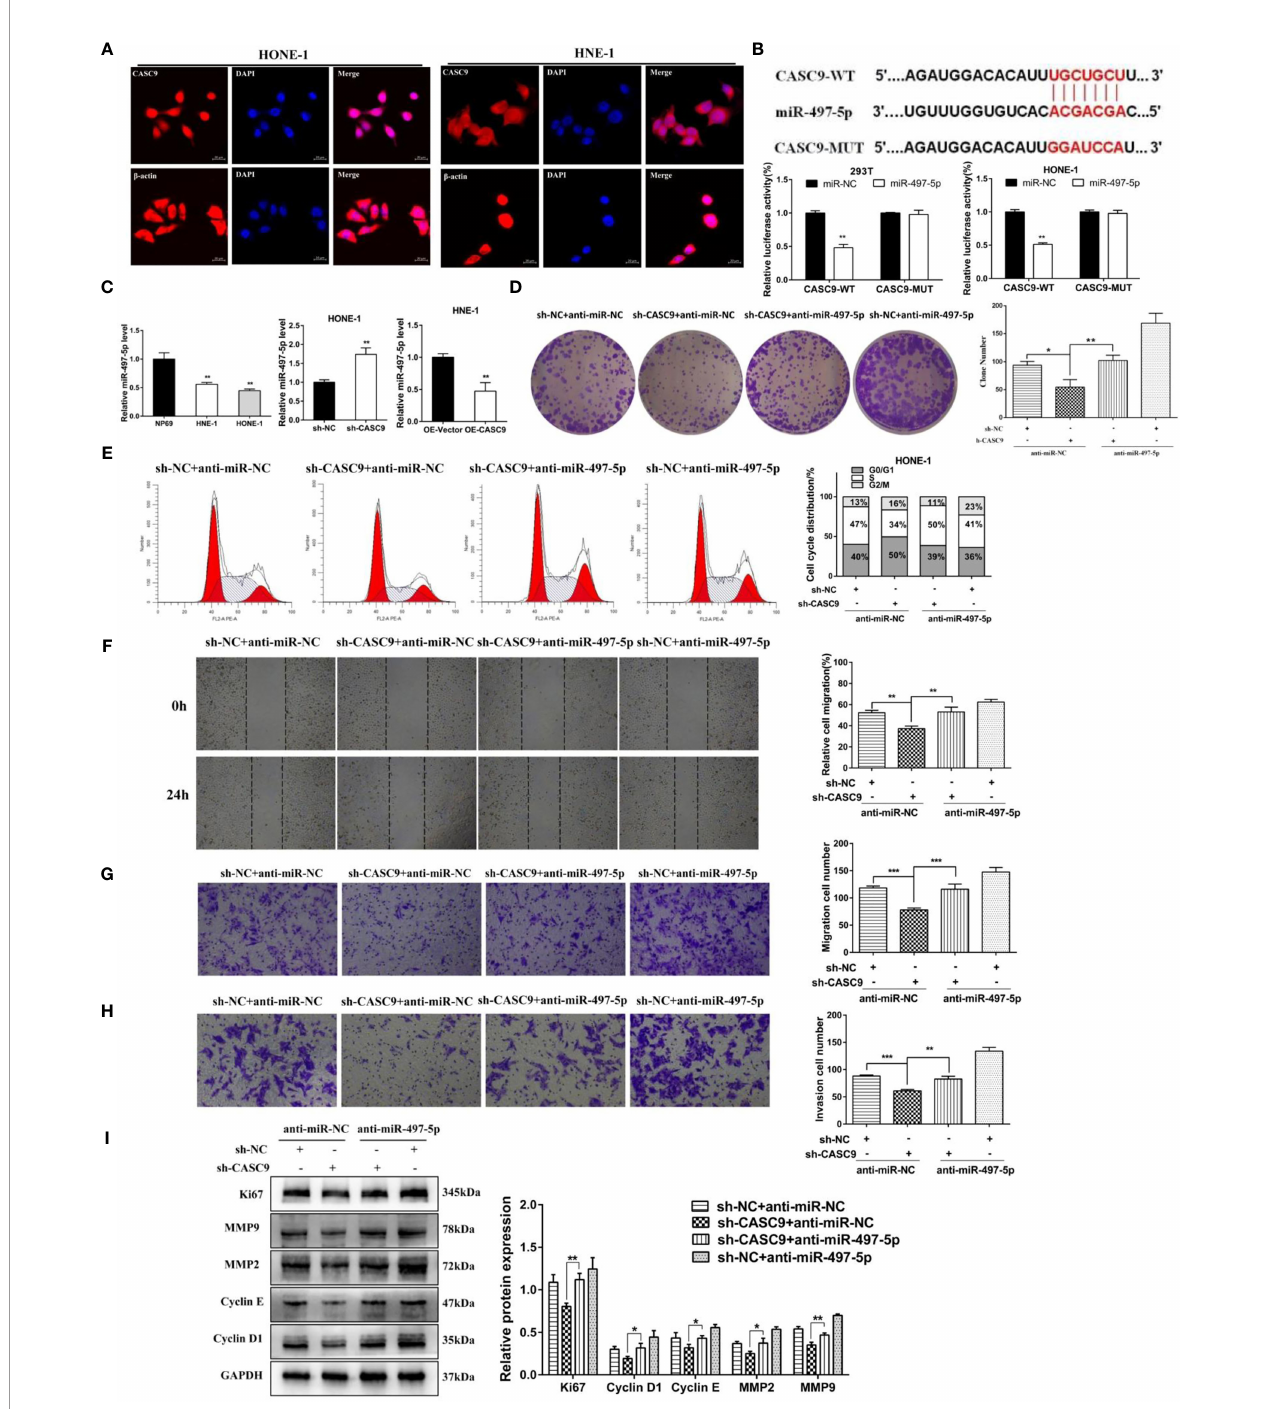
FIGURE 5 | miR-497-5p was a direct target of CASC9 and the abrogation of miR-497-5p reversed the inhibitory effects of the CASC9 knockdown on NPC cells. (A) RNA-FISH results revealed that CASC9 was distributed in both nucleus and cytoplasm of NPC cells. (B) The binding sites of miR-497-5p and CASC9 were predicted through bioinformatics analysis and con fi rmed by dual-luciferase reporter gene assay. (C) miR-497-5p expression was decreased and negatively associated with CASC9 in NPC cells. (D, E) Knockdown of miR-497-5p reversed the effect of silencing CASC9 on cell proliferation and cell cycle. (F, G) Knockdown of miR-497-5p reversed the effect of silencing CASC9 on cell migration. (H) Knockdown of miR-497-5p reversed the effect of silencing CASC9 on cell invasion. (I) The expression of proliferation and invasion-related proteins were determined using western blotting. *P < 0.05, **P < 0.01, ***P <